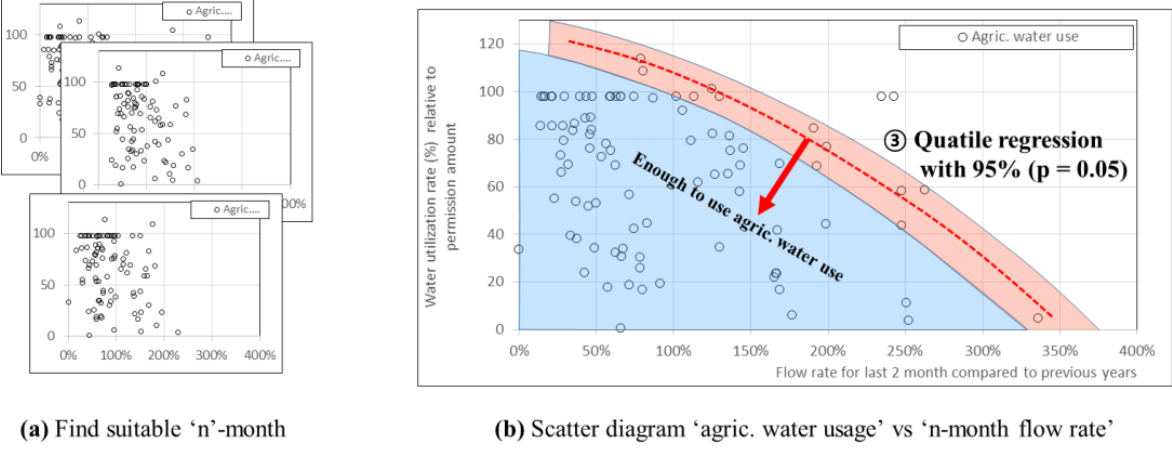
Figure 2. Diagram to derive the threshold curve of URP.